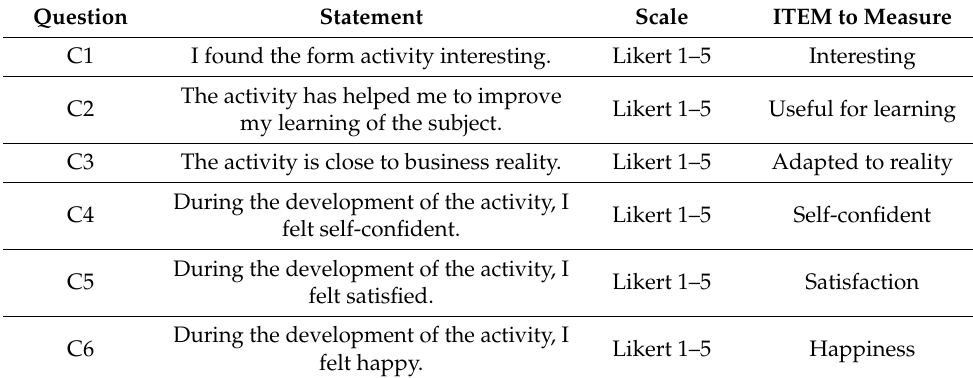
Table 4. Questions on the questionnaire for students’ perception analysis.